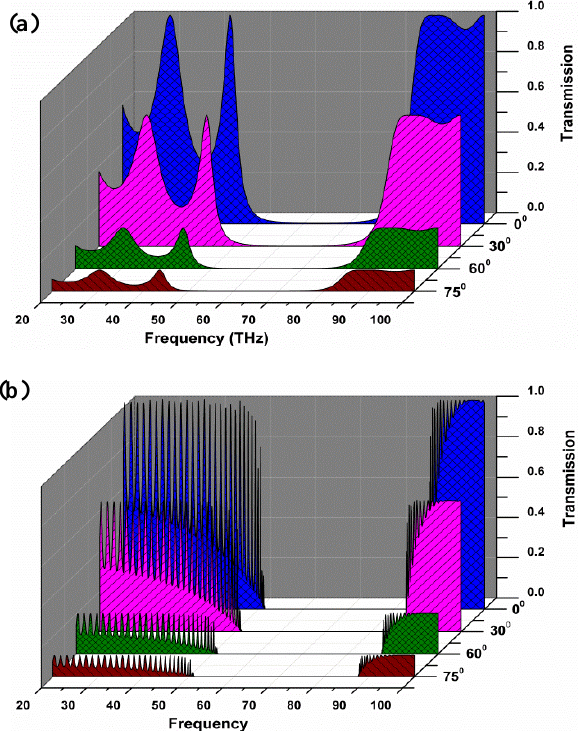
Figure 6: TE Transmittance spectrum of SbSBr based Conventional and Fibonacci Photonic crystal structures of (a) 5th and (b) 10th